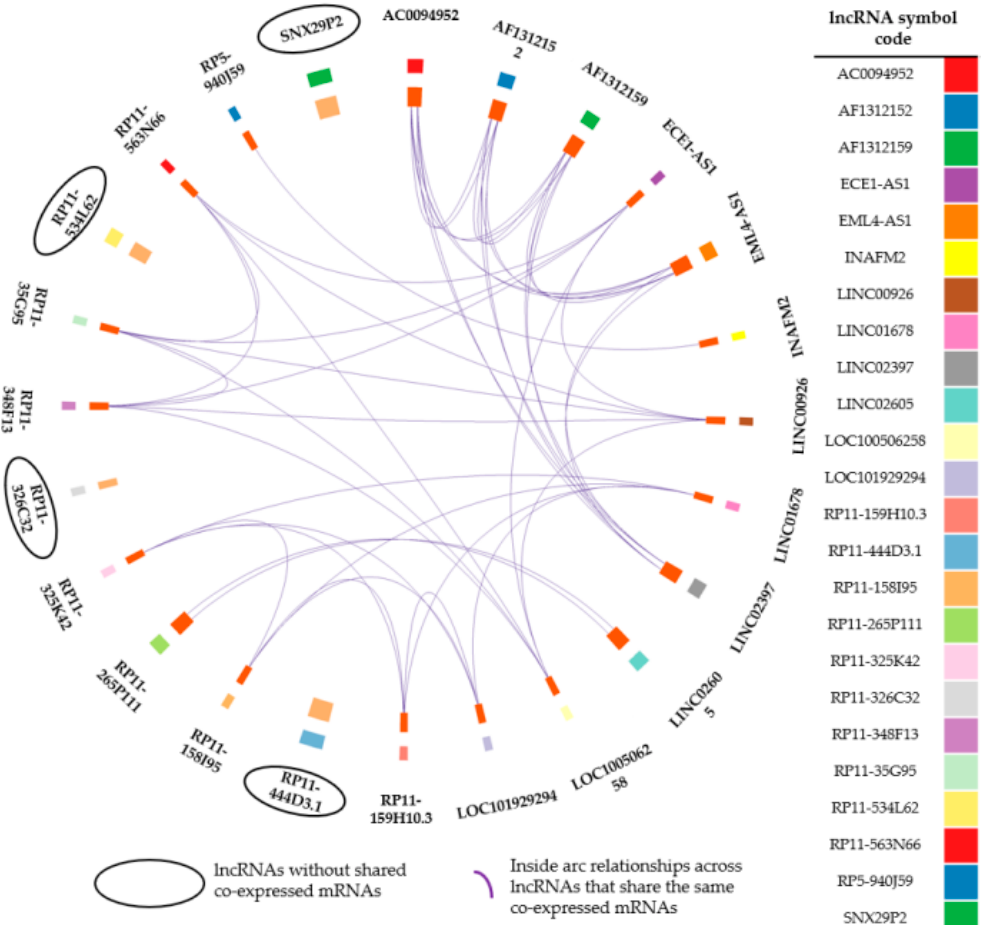
Figure 6. Circos plot shows overlap by lncRNAs and co–expressed mRNA lists of the 4 KEGG disease associated pathways. Circos outside reports lncRNA name, each one associated with its table colour. Circos inside arc represents for each lncRNA, mRNA memberships. Purple lines link the same gene that is shared by multiple gene lists (overlap). Dark orange colour represents the genes that appear in multiple lists and light orange colour represents genes that are unique to that gene list. A greater number of purple links and longer dark orange arcs implies greater overlap among lncRNA–mRNA lists.